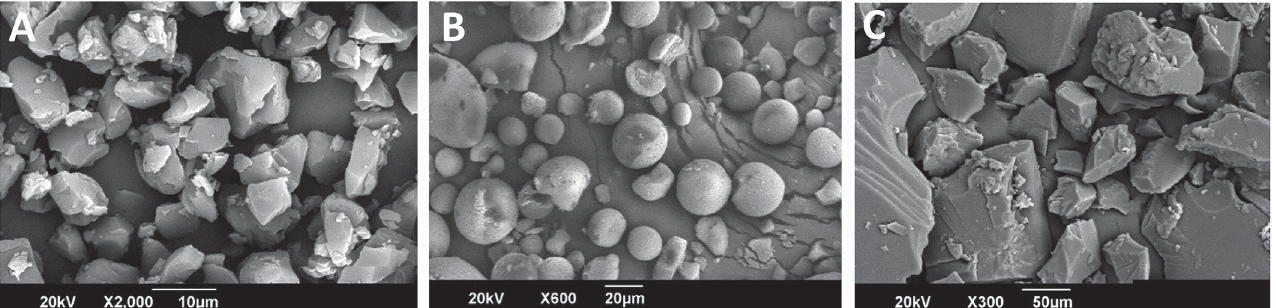
FIGURE 5 - SEM images: A) EUE, B) EUL, and C) SIPEC.